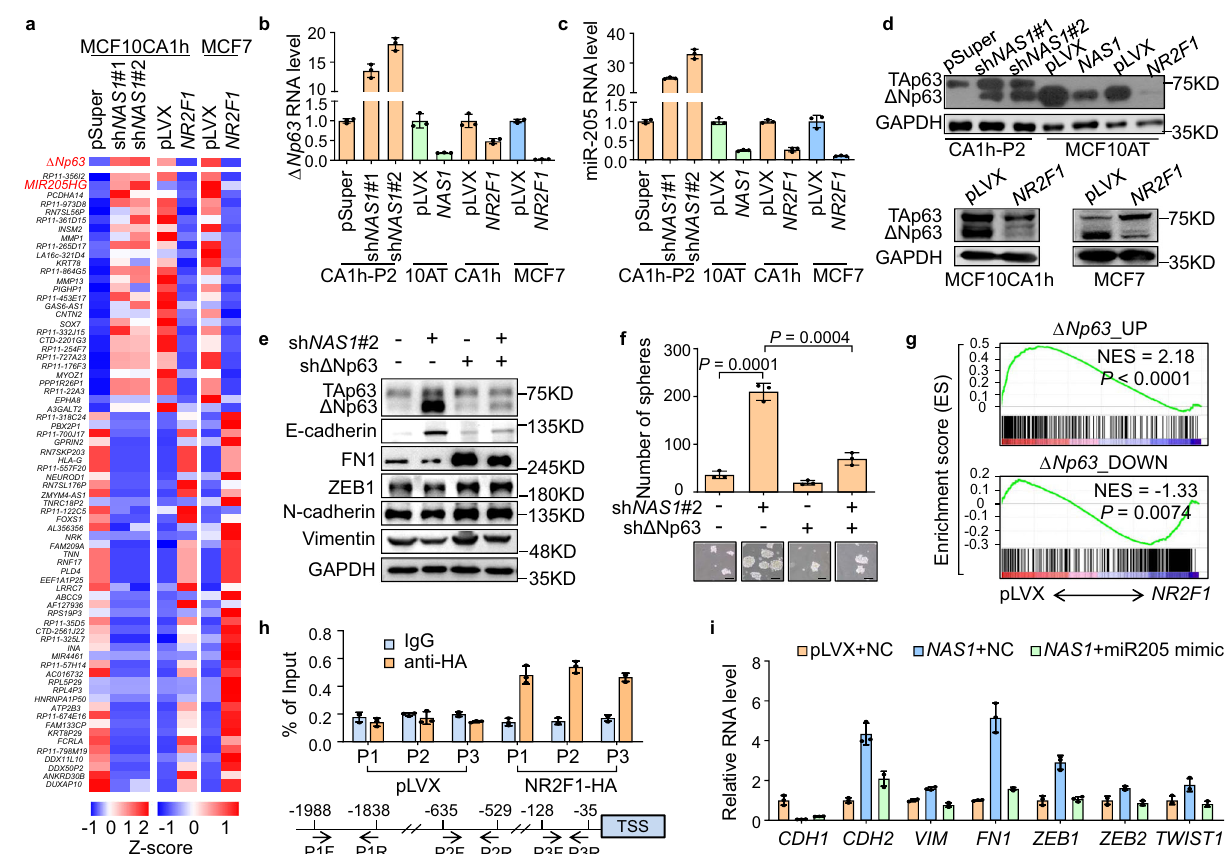
Fig. 6 NR2F1 mediates the role of NAS1 in dormancy by inhibiting Δ Np63 transcription. a Expression heatmap of genes affected by NAS1 and NR2F1 in both MCF10CA1h and MCF7. b qPCR veri fi cation of Δ Np63 regulation by NAS1 and NR2F1. c qPCR veri fi cation of miR-205 regulation by NAS1 and NR2F1. d Δ Np63 protein levels regulated by NAS1 or NR2F1. e , f EMT marker protein expression ( e ) and tumorsphere formation ( f , n = 3 culturing experiments) after Δ Np63 knockdown in CA1h-P2 cells with NAS1 knockdown. g GSEA analyses of the gene set upregulated and downregulated by Δ Np63 in MCF7 cells with NR2F1 overexpression versus control. h ChIP-qPCR analysis of NR2F1 binding to Δ Np63 promoter ( n = 3 replicates from one experiment). P1 – 3, primer pairs #1 – 3. i mRNA levels of EMT markers in MCF10AT with NAS1 overexpression and/or miR-205 mimic. Data represent mean ± SD. Statistical signi fi cance was determined by a two-tailed unpaired t test. Experiments were repeated at least three times independently with similar results; data from one representative experiment are shown. Scale bar, 100 μ